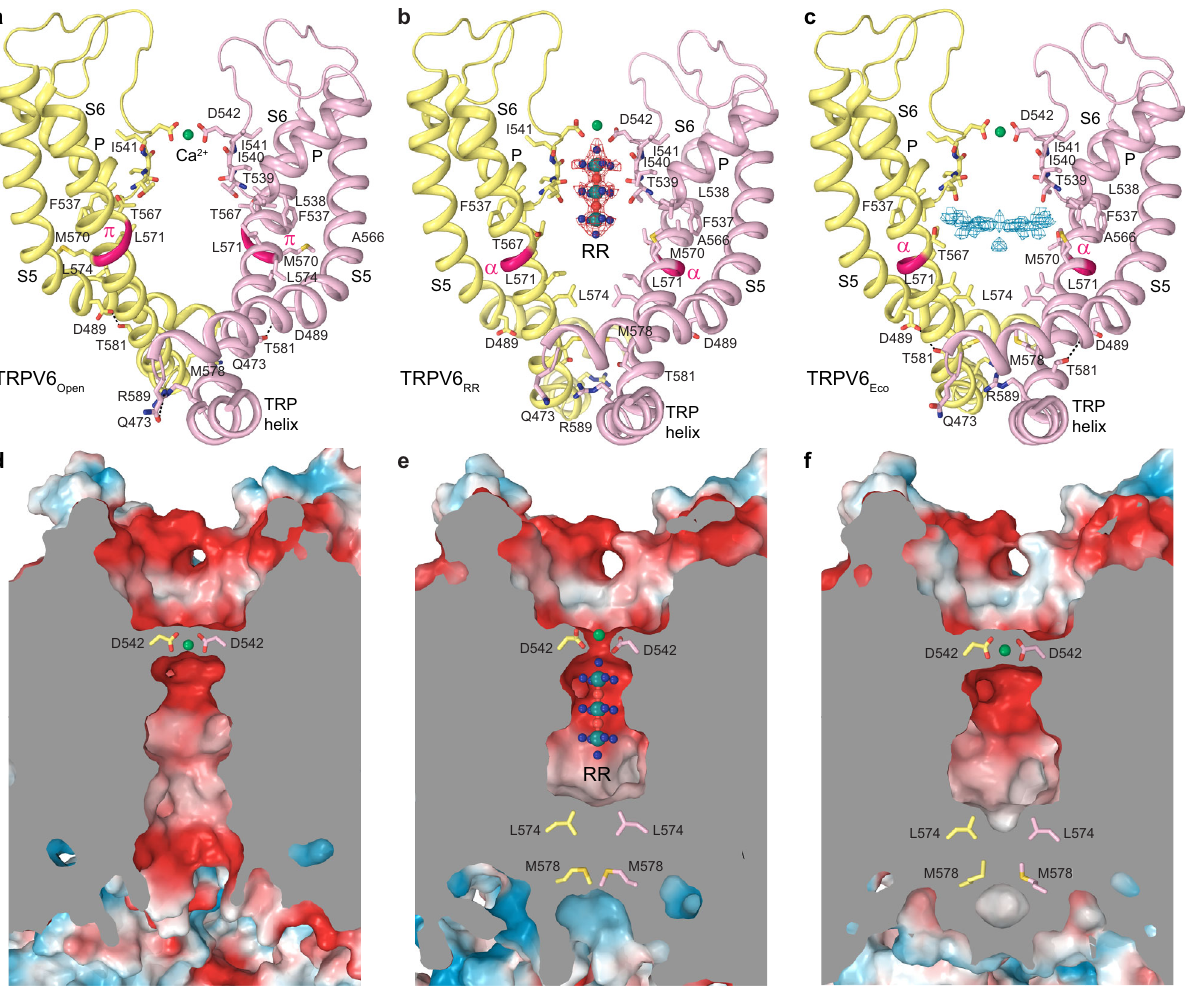
Fig. 3 Binding site of the ion channel blocker RR. a – c Structure of the ion channel pore in TRPV6 Open ( a ), TRPV6 RR ( b ), and TRPV6 Eco ( c ) viewed parallel to the membrane. Only two of four subunits are shown, with the front and back subunits omitted for clarity. Also shown is the molecule of RR and residues contributing to RR binding, calcium selectivity, gating, or being involved in state-speci fi c interactions. Red and blue mesh shows density for RR and non- protein density in the TRPV6 Eco pore, respectively. Interactions between Q473 and R589 as well as D489 and T581 are indicated by dashed lines. The region that undergoes α -to- π transition in S6 is highlighted in bright pink. Calcium ions are shown as green spheres. d – f Coronal sections of the pore in TRPV6 Open ( d ), TRPV6 RR ( e ), and TRPV6 Eco ( f ), with the surface colored by electrostatic